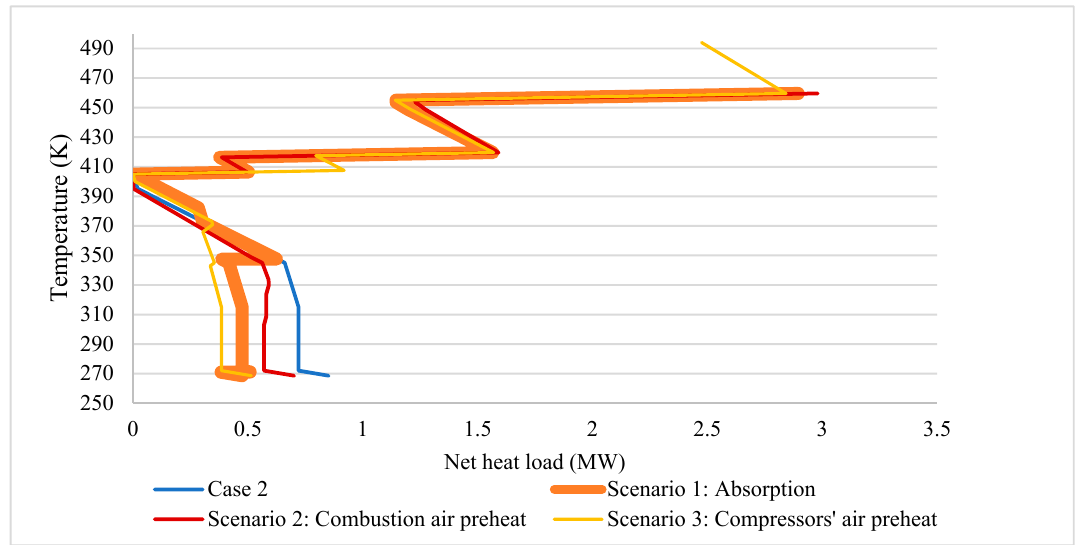
Figure 20. GCC of each synergy scenario.